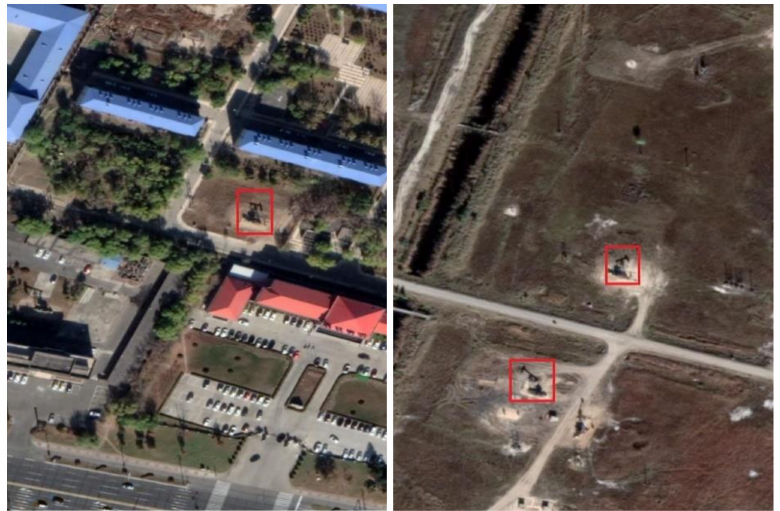
Figure 2. Sample images of oil well pump jacks from optical remote sensing images (red rectangle boxes show the location of the oil well pump jacks).